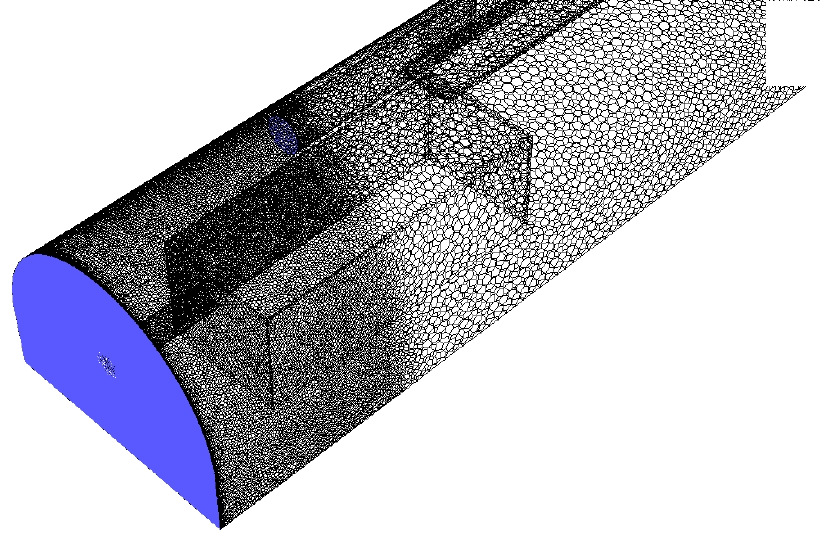
Figure 3. Fragment of the discrete model of the studied dog heading. Table 1. The major parameter setting.